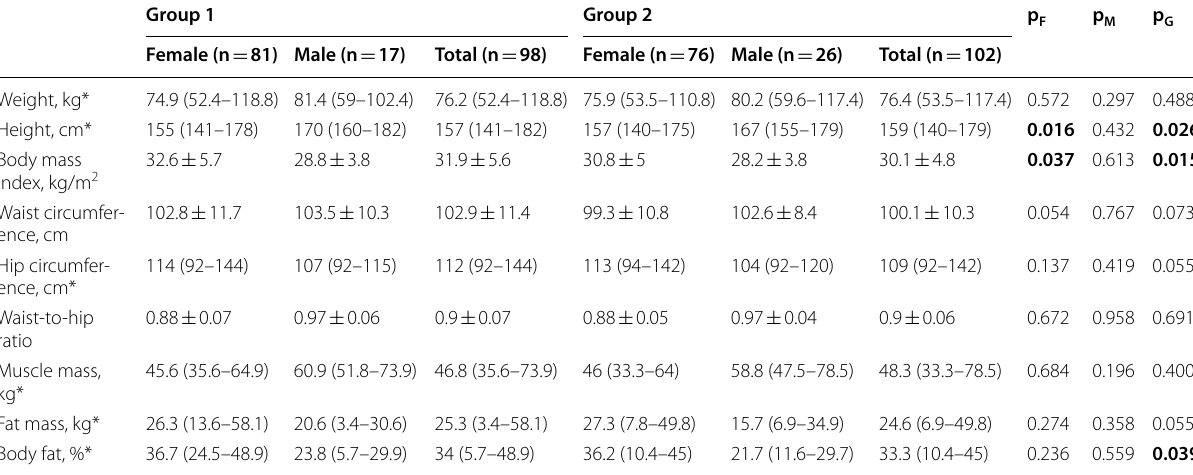
P -value less than 0.05 ( p < 0.05) is statistically significant p F ; significance of difference between females in Group 1 and Group 2. p M ; significance of difference between males in Group 1 and Group 2. p G ; significance of difference between Group 1 and Group 2 n number * Given as median